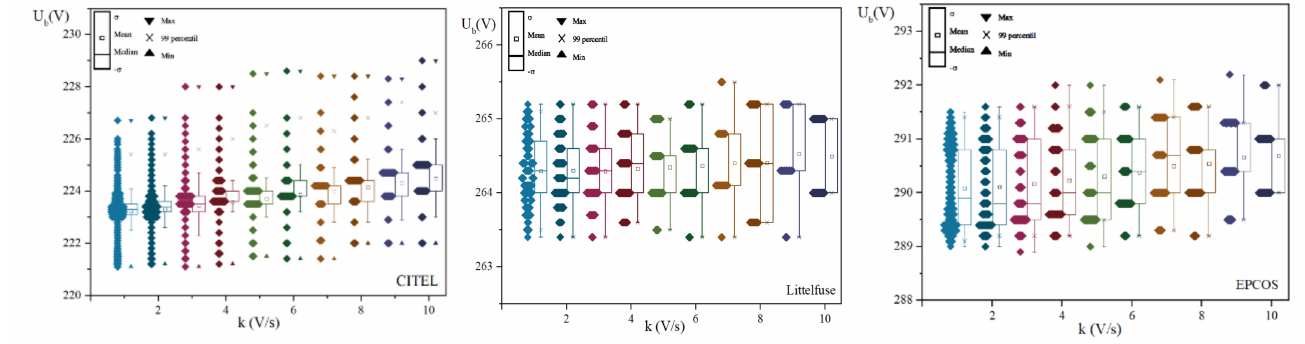
Figure 7. Standard deviation, mean, median, maximum, minimum and 99 percentiles of measurement results in the presence of gamma radiation for CITEL, Littelfuse and EPCOS GFSA, respectively, for all voltage increase